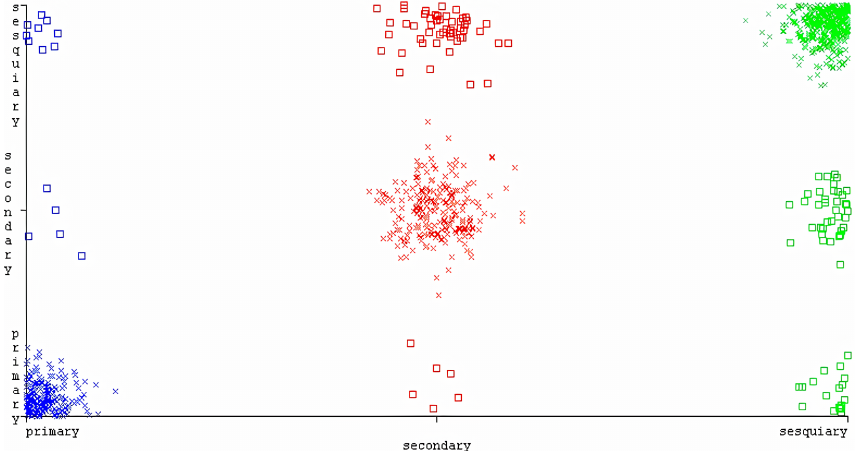
Figure 10. Visualization of classification results for Ontake eruption